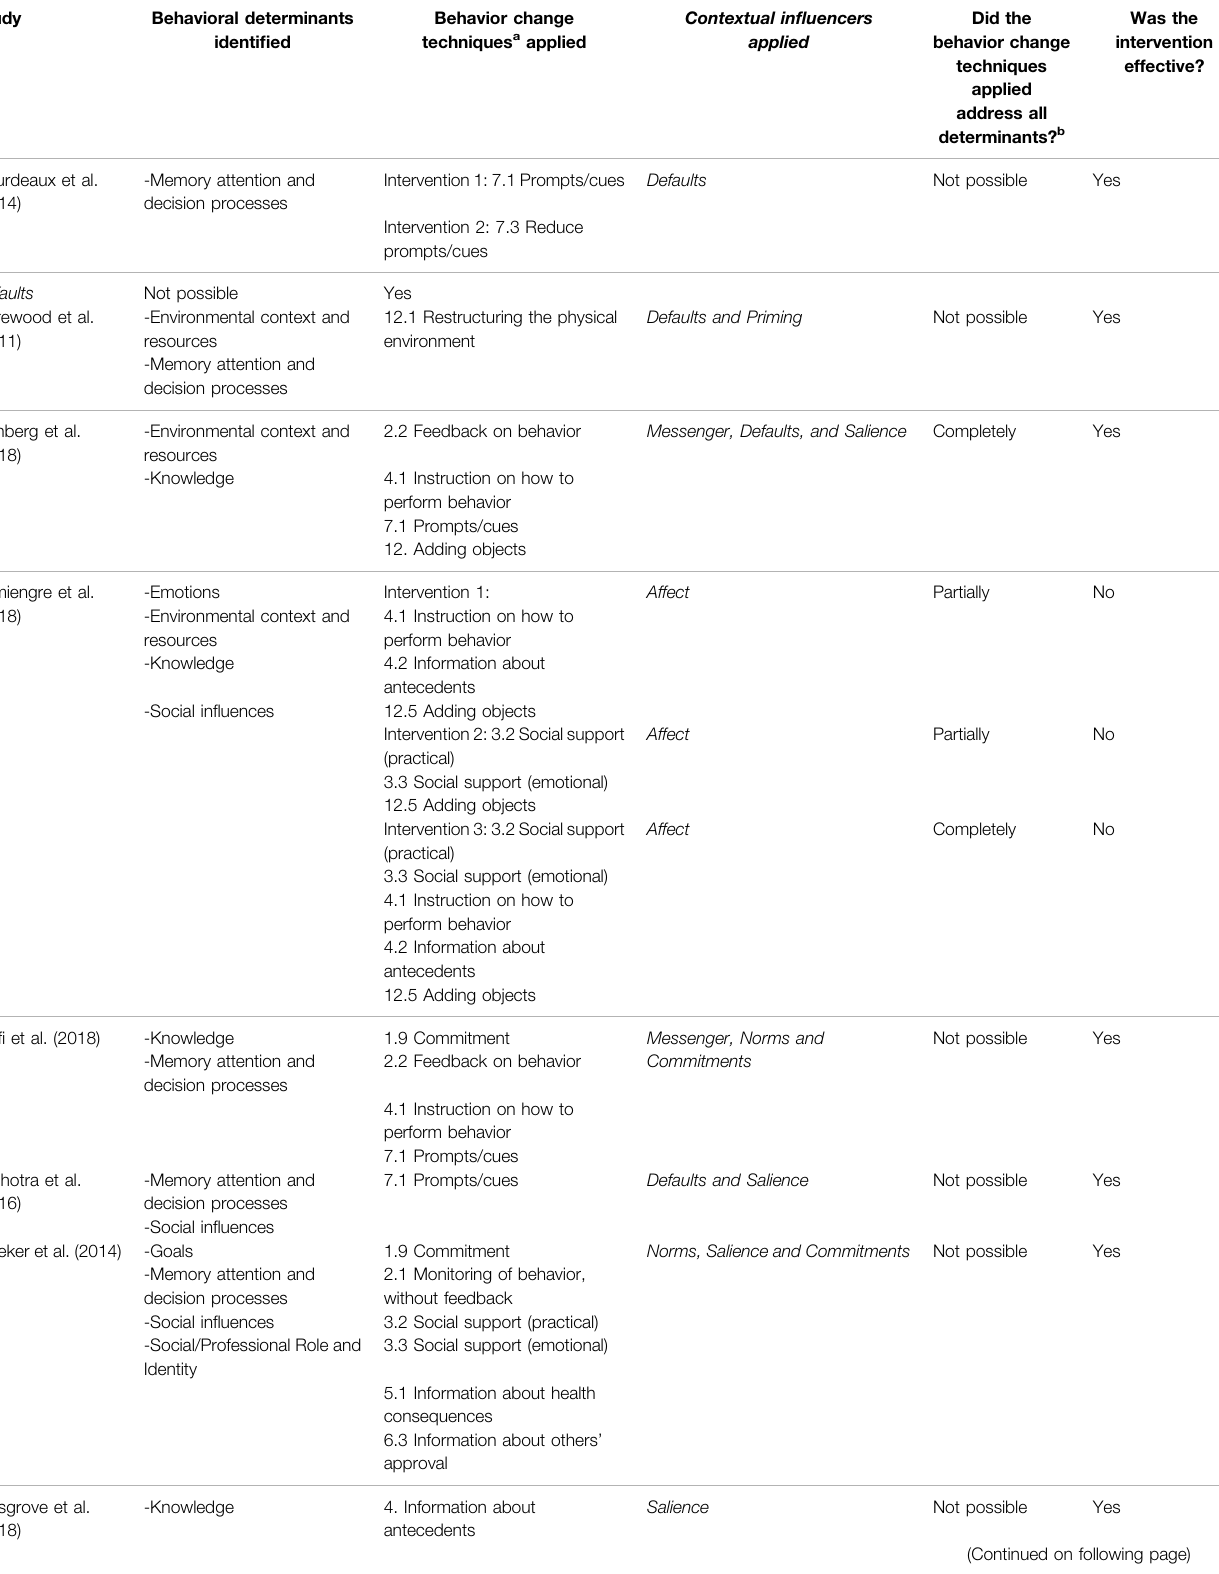
TABLE 3 | Behavioral determinants identi fi ed in each study, along with the techniques recommended to in fl uence them, the behavior change techniques/ contextual in fl uencers applied in each intervention, whether the techniques applied addressed all the determinants identi fi ed, and whether the interventions were